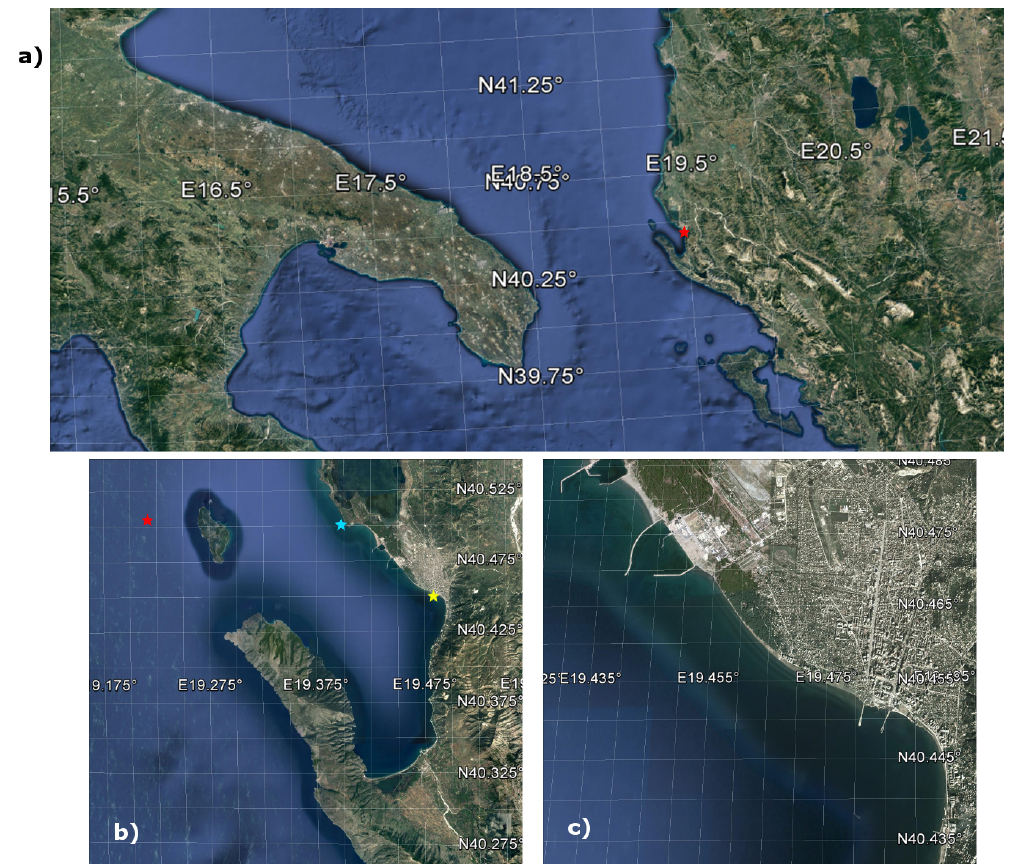
Figure 1. (a) Location of Vlorë, (b) wave hindcast extraction point (red star), Vlorë Harbour (yellow star), wind data measurement point (blue star); (c) view of Vlorë